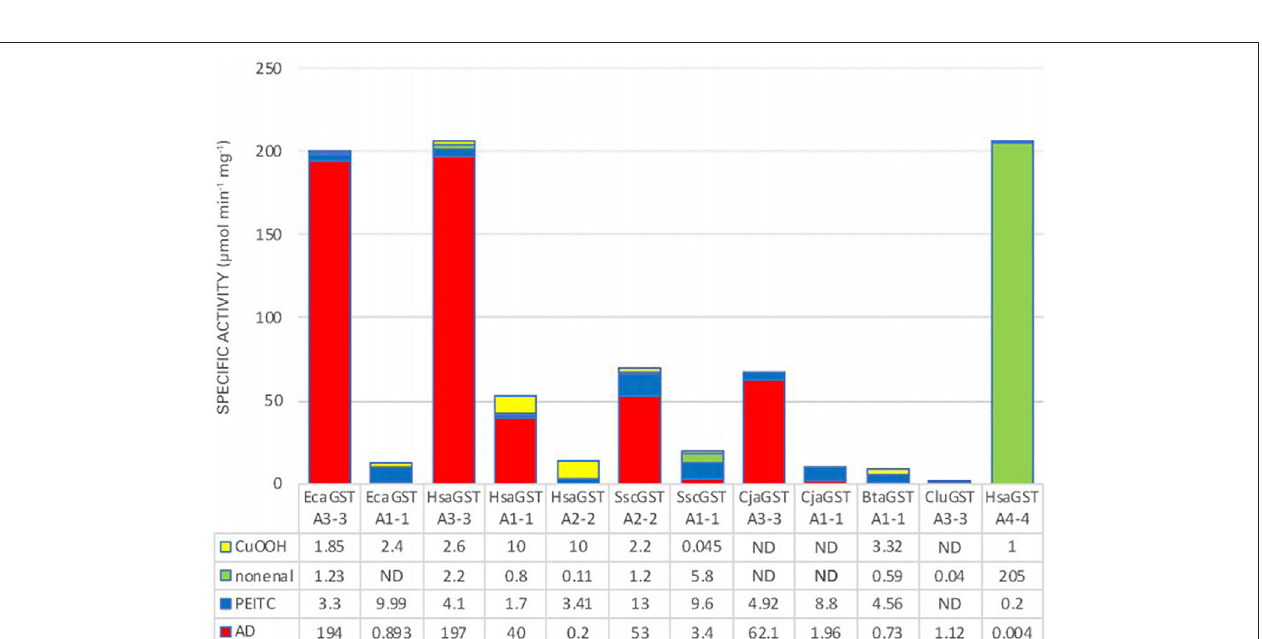
FIGURE 5 | Stacked speci fi c activities with four physiologically relevant substrate categories. CuOOH, cumene hydroperoxide; nonenal, trans -2-nonenal; PEITC, phenethyl isothiocyanate; AD, 5-androsten-3,17-dione. The speci fi c activities are given in units of μ mol min − 1 mg − 1 and compiled from EcaGST A3-3 (Lindström et al., 2018); EcaGST A1-1 (A. Ismail, unpublished); HsaGST A3-3 and HsaGST A1-1 (Johansson and Mannervik, 2001); HsaGST A2-2 (Johansson and Mannervik, 2001; Zhang et al., 2012); SscGST A2-2 (Fedulova et al., 2010); SscGST A1-1 (Fedulova et al., 2011); CjaGST A3-3 and CjaGST A1-1 (Ismail et al., 2021); BtaGST A1-1 (Raffalli-Mathieu et al., 2007); CluGST A3-3 (A. Ismail, unpublished); HsaGST A4-4 (Hubatsch et al.,